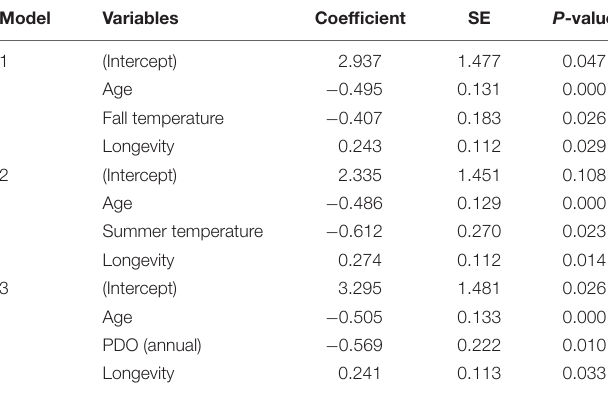
TABLE 3 | Estimated coefficients, standard errors (SE) and corresponding P -values of the three generalized linear mixed-effects models showing how reproductive success at old ages is affected by age and by fall temperature, summer temperature and Pacific Decadal Oscillation (PDO) for bighorn sheep females born at Ram Mountain, Canada, from 1973 to